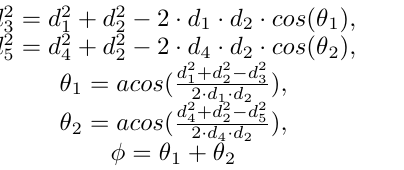
Fig. 4. Distance between marker C7 and the mid-point between LBHP and RBHP d 2 = d 2 + d 2 − 2 · d 1 · d 2 · cos ( θ 1 ) , 3 1 2